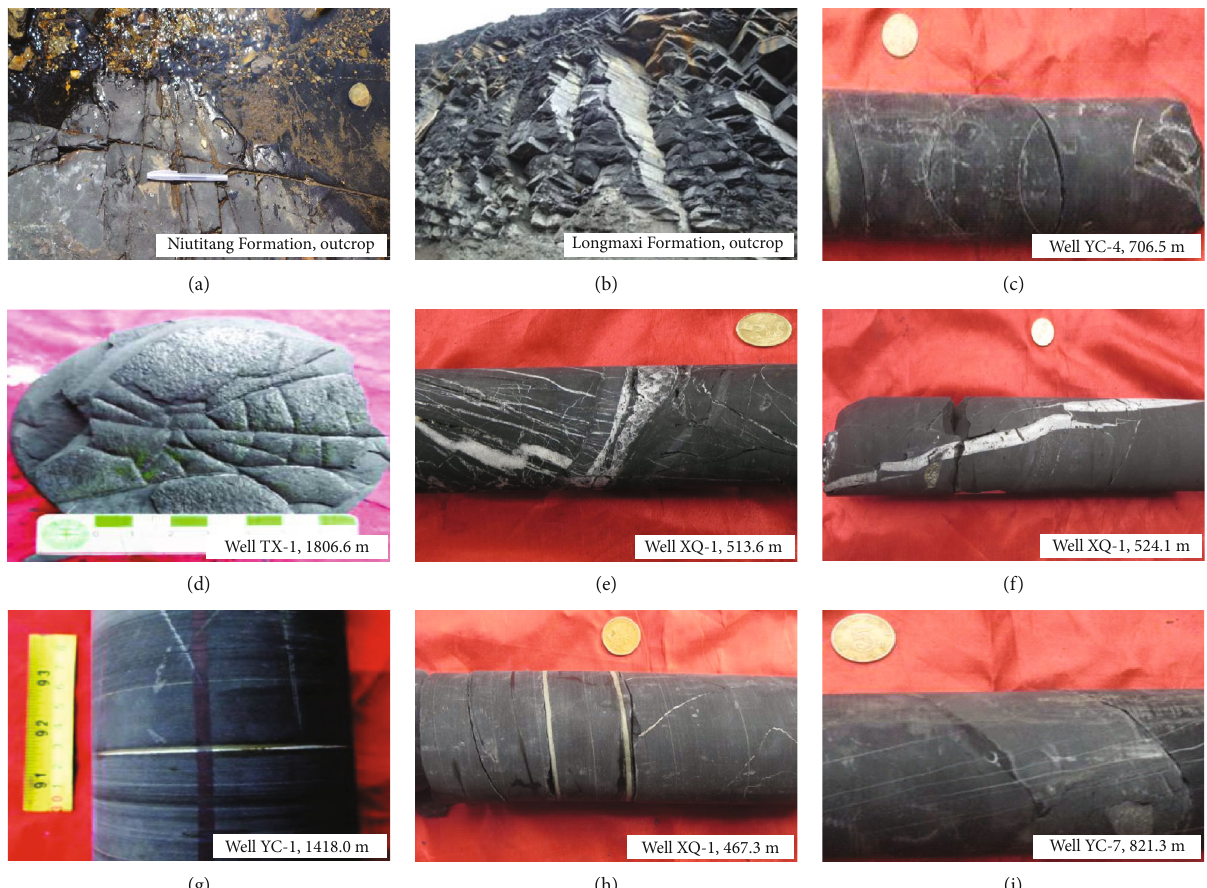
Figure 2: Shale fracture development characteristics in the target layer of southeastern